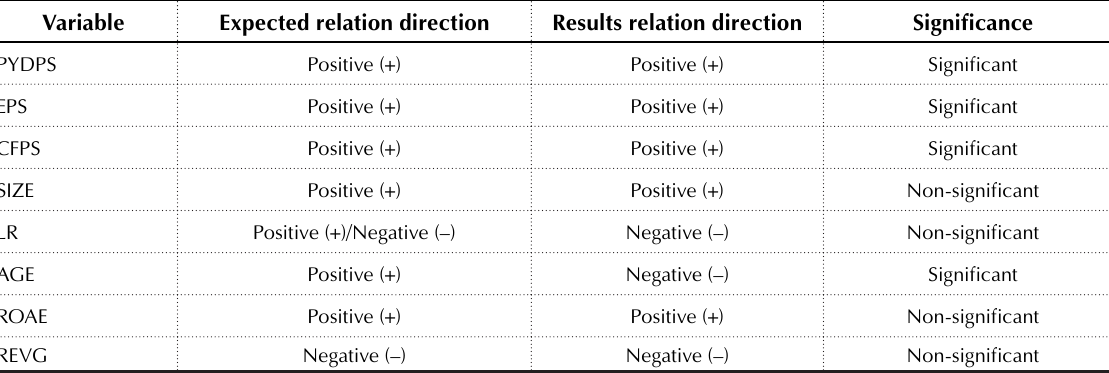
Table 12. Summary of model (B) results of coefficients relationship direction and